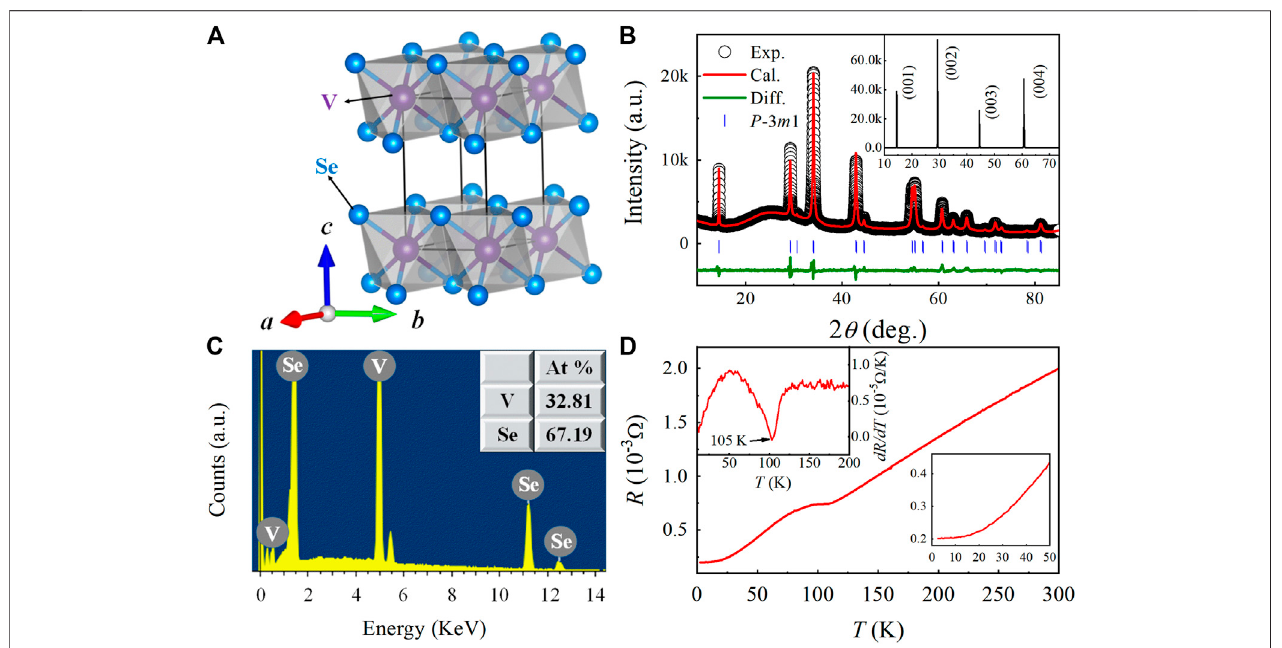
FIGURE 1 | (A) Crystal structure of 1 T -VSe 2 . (B) Room temperature powder X-ray diffraction pattern. Inset: Single-crystal XRD pattern. (C) Energy dispersive spectrum for single crystalline 1 T -VSe 2 . (D) Resistance for a single crystal as a function of temperature. Inset: The fi rst derivative of the resistance d R /d T .